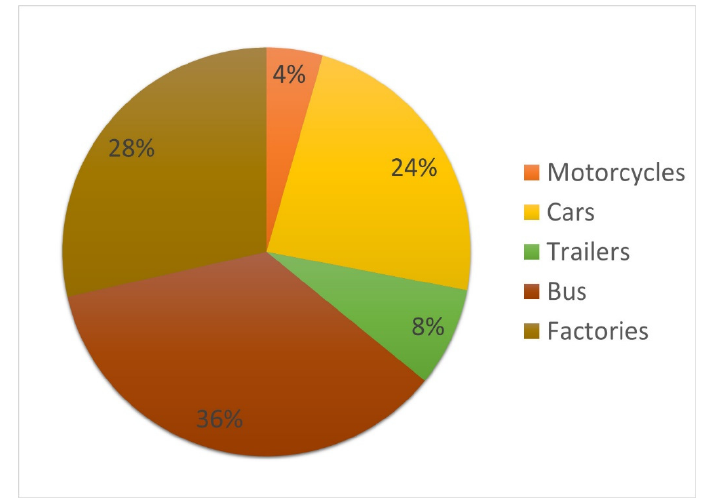
Figure 7. What do you think contaminates more?